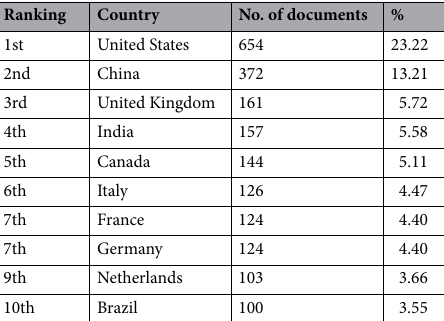
Ranking Country No. of documents